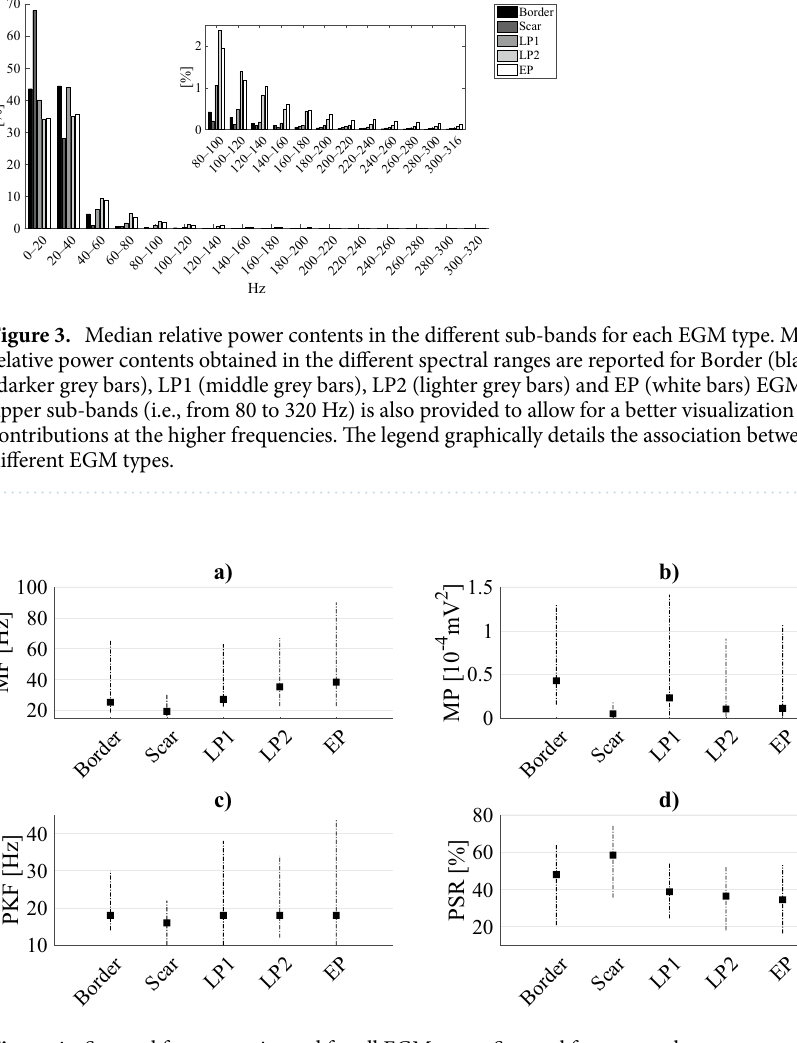
Figure 4. Spectral features estimated for all EGM types. Spectral feature results are reported as medians (black squares) and 5th and 95th percentiles. Specifically, in ( a ) the distributions of mean frequency (MF) values are represented for all EGM types, whereas in ( b – d ) those referred to the mean spectral power (MP), the maximum or peak frequency (PKF) and the power spectrum ratio (PSR),